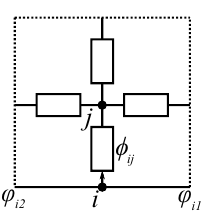
Figure 7. The element on the